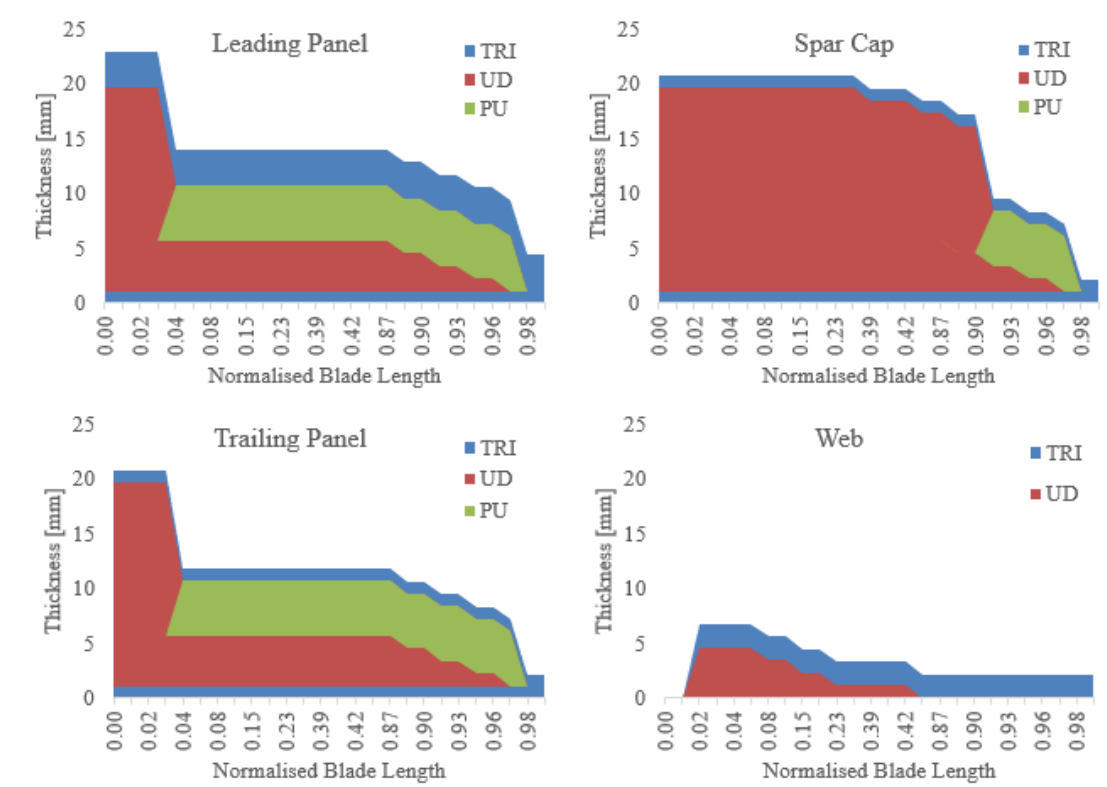
Figure 4. Layups details of each components of the wind turbine blade.